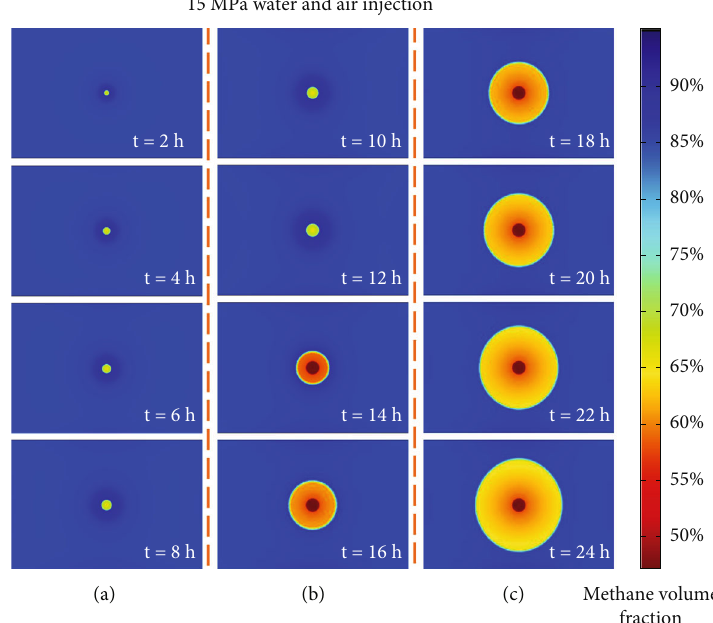
Figure 10: Contour of V